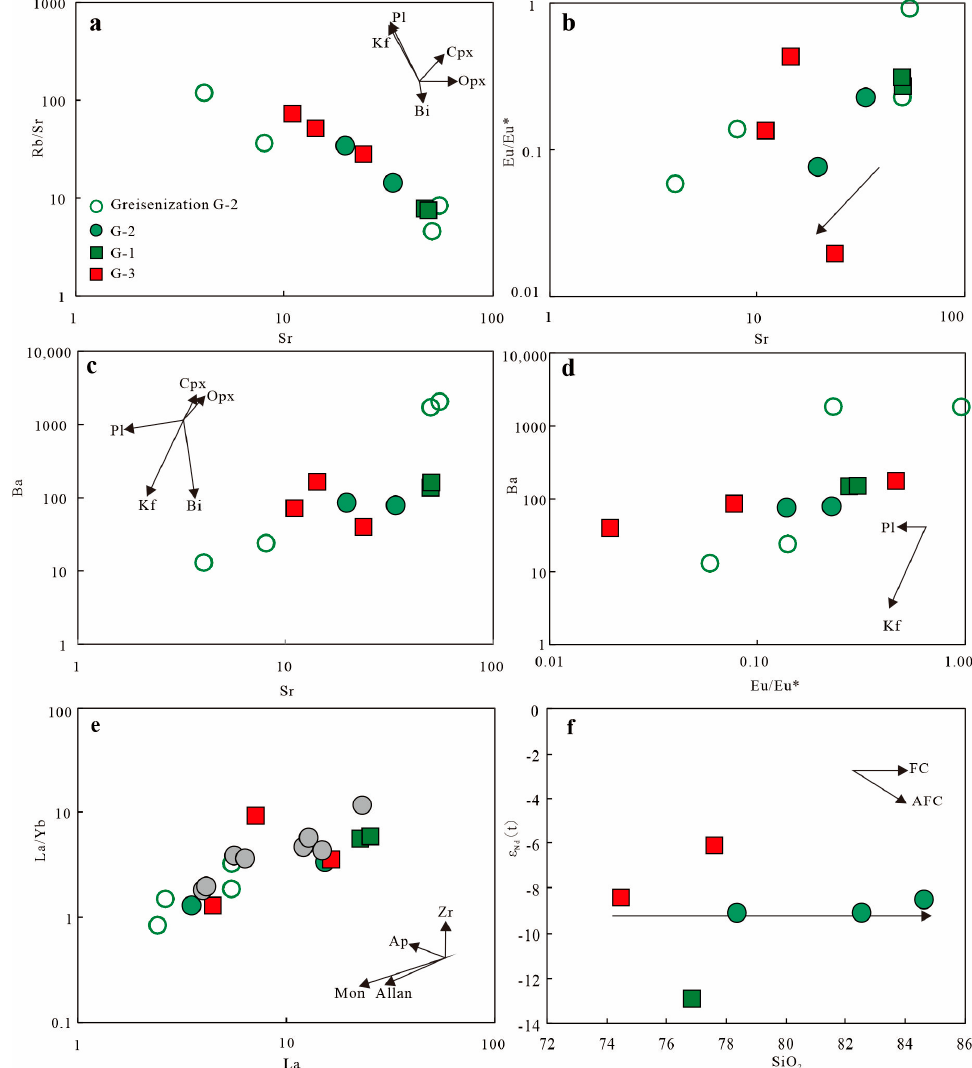
Figure 16. ( a ) Rb/Sr versus Sr diagram, ( b ) Eu/Eu* versus Sr diagram, ( c ) Ba versus Sr diagram, ( d ) Ba versus Eu/Eu* diagram, ( e ) La/Yb versus La diagrams, ( f ) ε Nd (t) versus SiO 2 diagram; Zr- zircon, Ap- apatite, Mon- monazite, Allan- allanite, Opx- orthopyroxene, Cpx- clinopyroxene, Kf K-felspar, Pl- plagioclase, Bi- biotite, FC- fractional crystallization, AFC- assimilation. Furthermore, Zr + Nb + Y contents of the Chuankou complex vary from 75.57 to 187.05 ppm, and the Rb/Ba ratios range from 1.33 to 39.41. An obvious negative correlation trend is exhibited on the Zr + Nb + Y versus Rb/Ba diagram, coinciding with the Sandy Cope granite field, indicating the common regulations of highly fractionated granite (Figure 17).